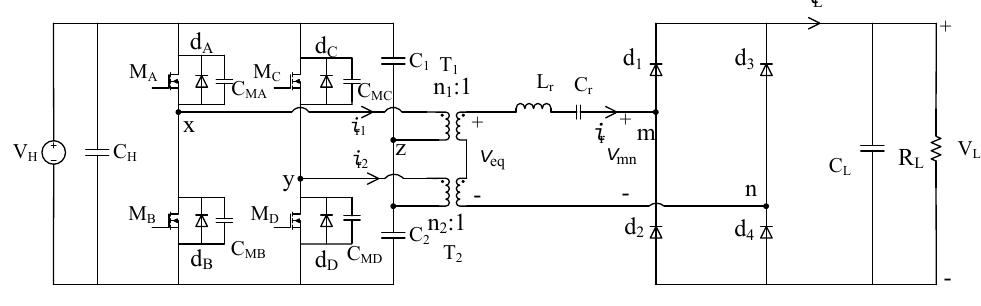
Figure 1. The topology of the Dual-Transformer DC-DC Resonant